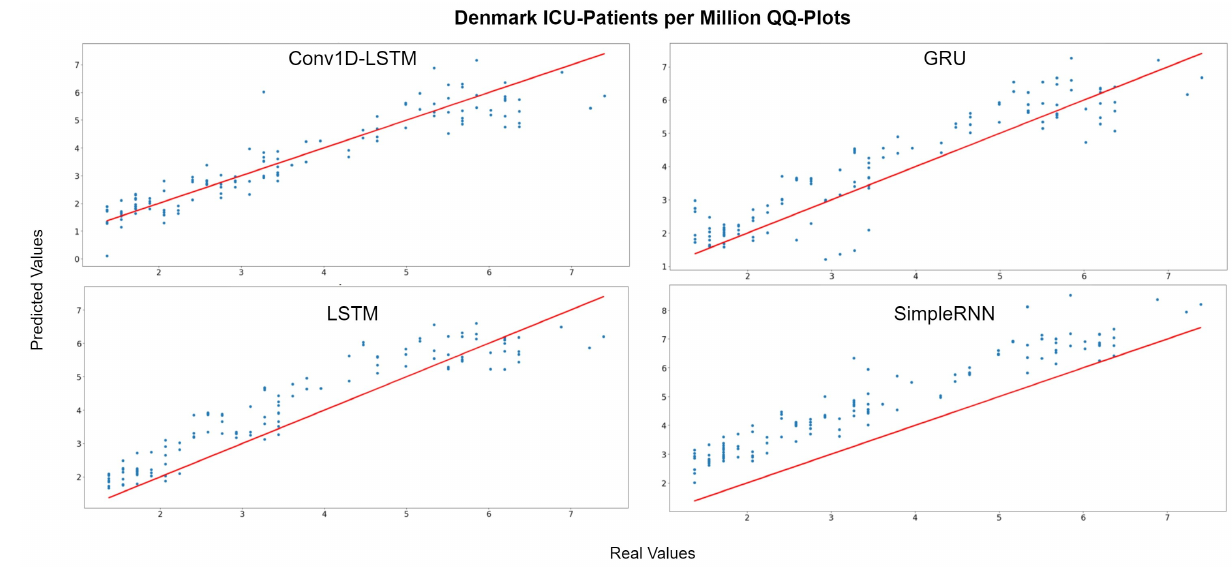
Figure 13. Denmark ICU-Patients per million QQ-Plot for each method.